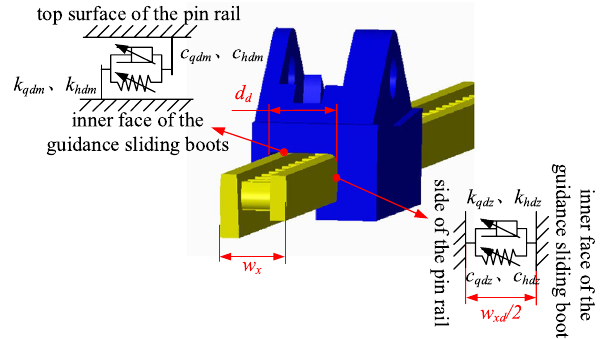
Figure 5. Schematic diagram of the guidance sliding boots in contact with the pin